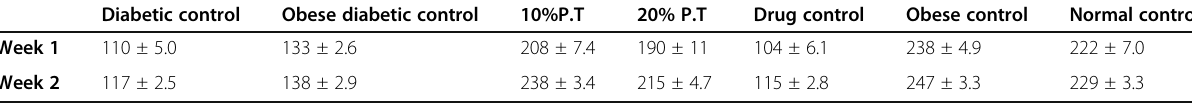
Table 5 Weekly feed intake of the rats during treatment of diabetic rats Diabetic